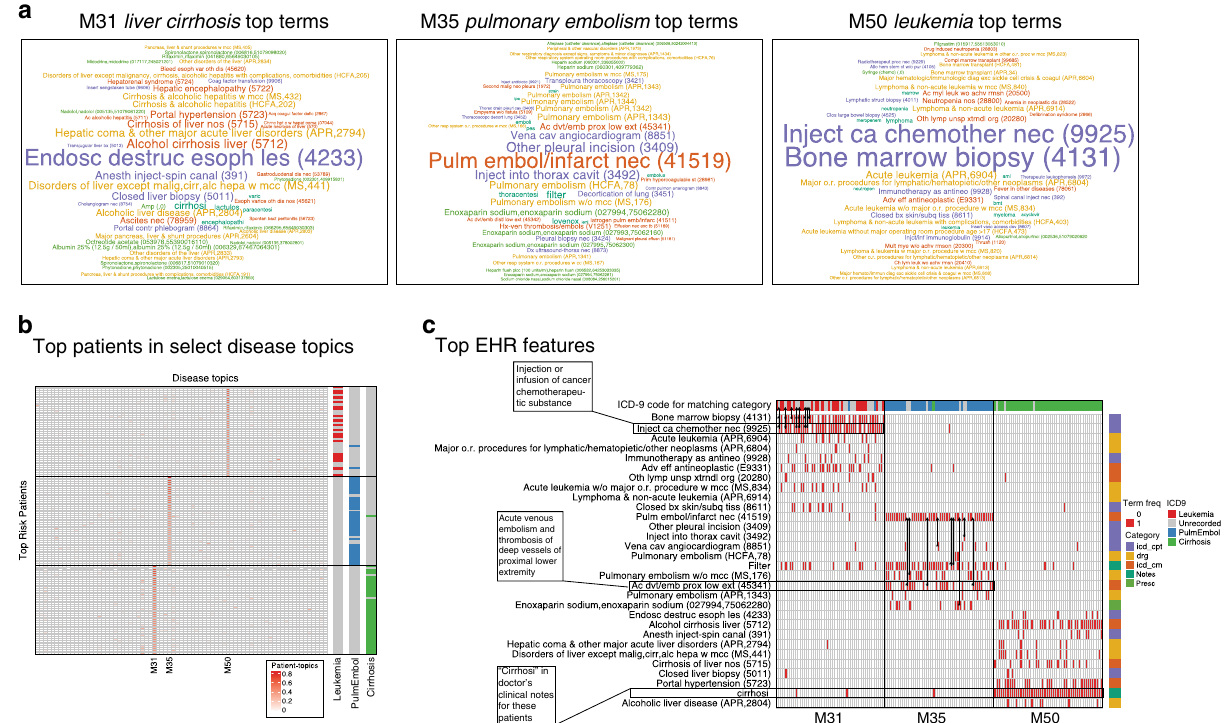
Fig. 3 Prioritize patients by disease mixture from MIMIC-III dataset. a Word clouds of the three topics with colors indicating different data types and font size proportional to the probabilities of the EHR codes under that topic. b We selected top 50 patients under three of the learned topics for illustration. These topics are displayed as word clouds where the size of the word is proportional to their probabilities under the topic. The heatmap indicates patient mixture memberships for the topics. The color bar on the right of the heatmap indicates the actual diagnoses of the diseases related to each of the topics, namely leukemia, pulmonary embolism, and cirrhosis. c Top EHR codes of the high-risk patients. The top ten EHR codes (rows) from each topic were displayed for the top 50 patients (columns) under each topic. We highlighted some evidence (asterisks) as why some of the patients in absence of ICD-9 codes were prioritized as high risk by our method based on their relevance to the diseases of interests (i.e., leukemia, pulmonary embolism, and